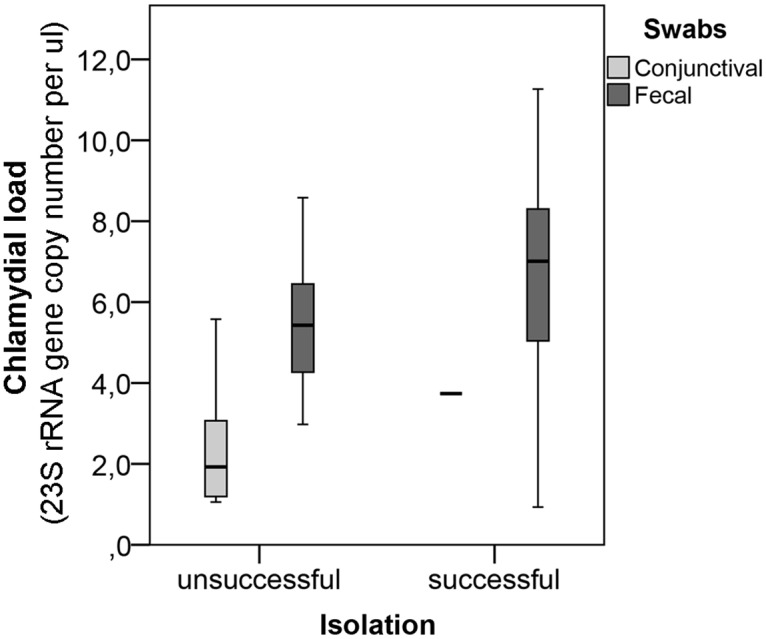
Comparison between the bacterial load of successful and failed isolations, depending on the anatomical site of sampling.Bacterial load of the clinical samples used for isolation expressed as 23S rRNA gene copy numbers per μl in a logarithmic scale (ln). The bacterial load of successfully isolated clinical swabs is compared to unsuccessful isolations while fecal and conjunctival swabs are presented separately.